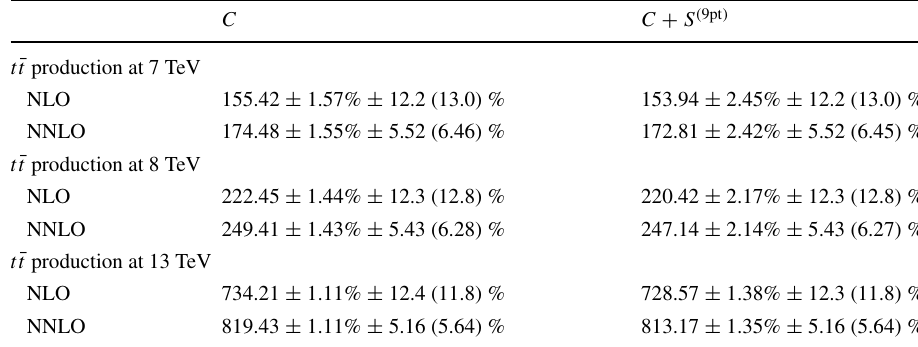
Table 11 Same as Table 9, now for top-quark pair-production at √ s = 7 , 8 and 13 TeV